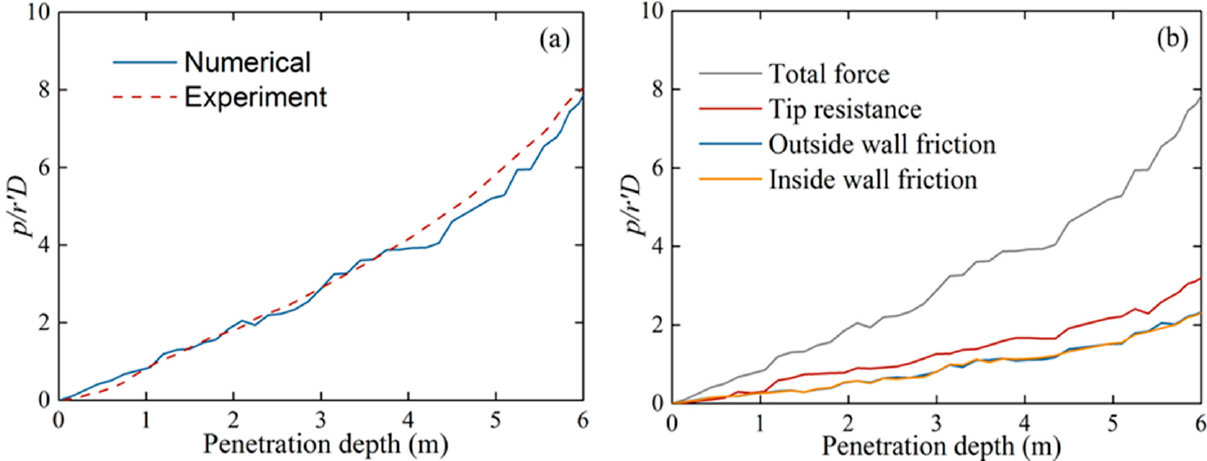
Figure 4. Jacked penetration resistance: ( a ) Numerical and centrifuge test results for penetration resistance; ( b ) Decomposition of penetration resistance from numerical results.